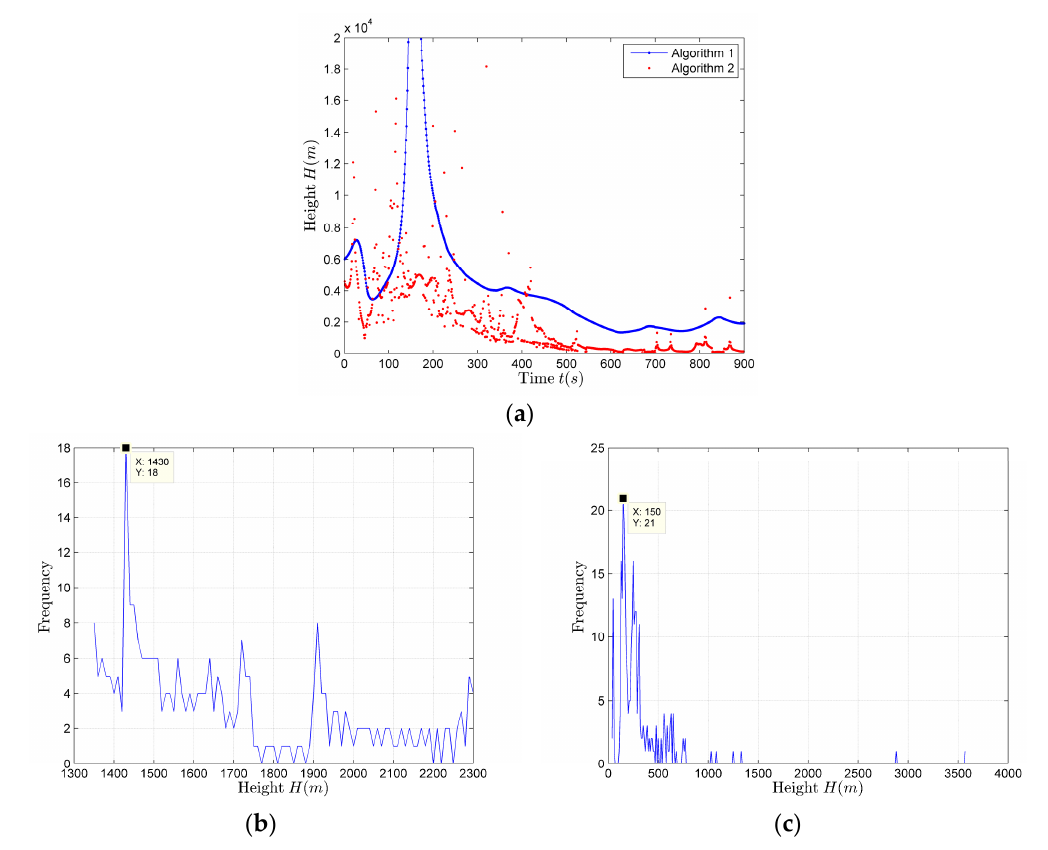
Figure 21. The height estimation results of the aerial target. ( a ) The height estimation results of the two algorithms; ( b ) The histogram statistical results of Algorithm 1; ( c ) The histogram statistical results of Algorithm 2.